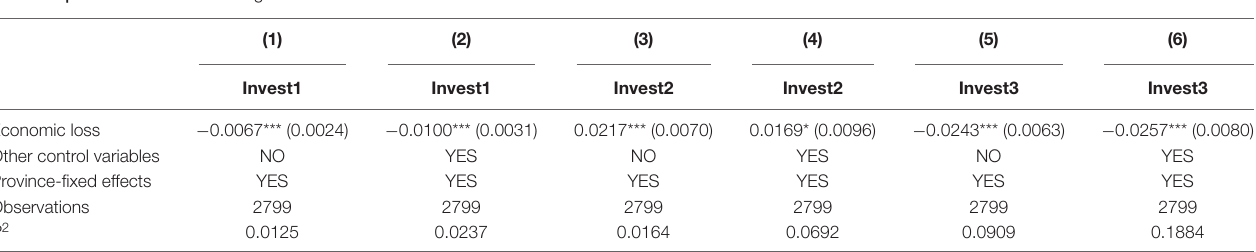
TABLE 7 | Robustness test 3: Using actual disaster losses instead of the climate shock index.